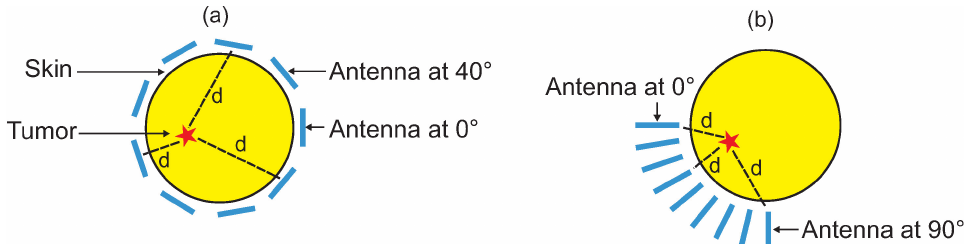
Figure 4. Antenna covering nine positions around the breast using: ( a ) the traditional CMI and ( b ) the proposed approach.